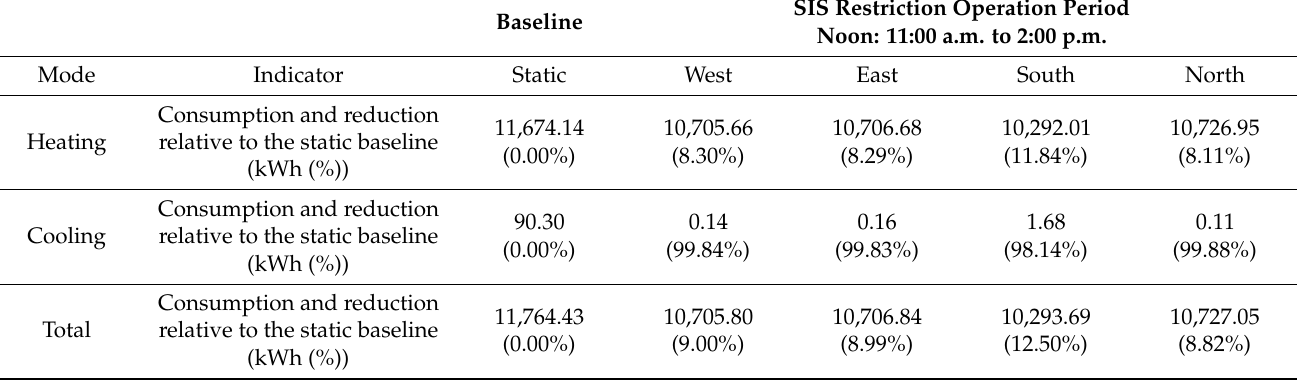
Table 13. Comparison of annual space heating and cooling energy consumption when a single window of the prototypical detached house model is forced open around